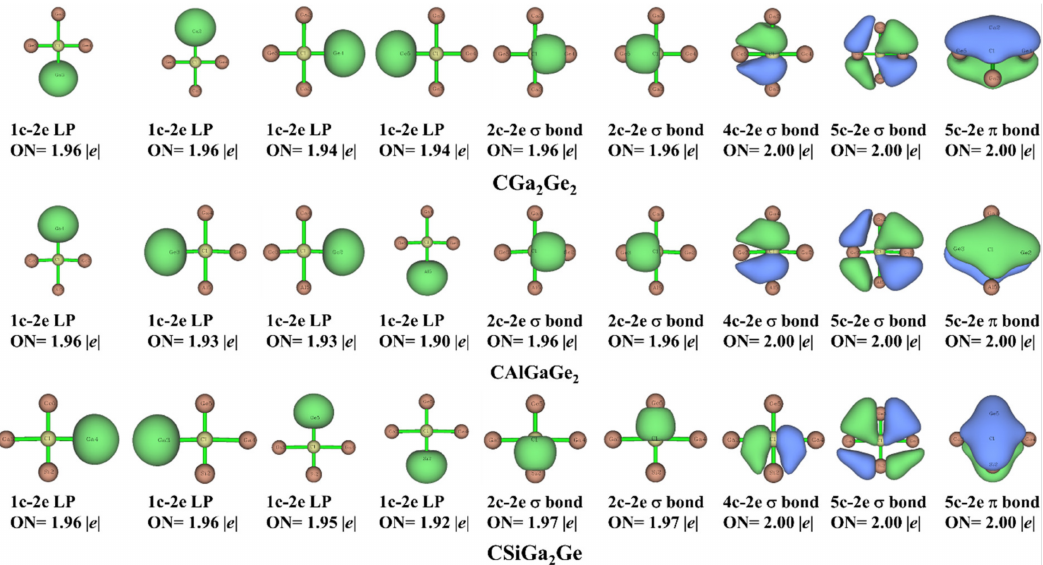
Figure 7. AdNDP bonding patterns of the systems in trans isomer with the occupation numbers (ONs).